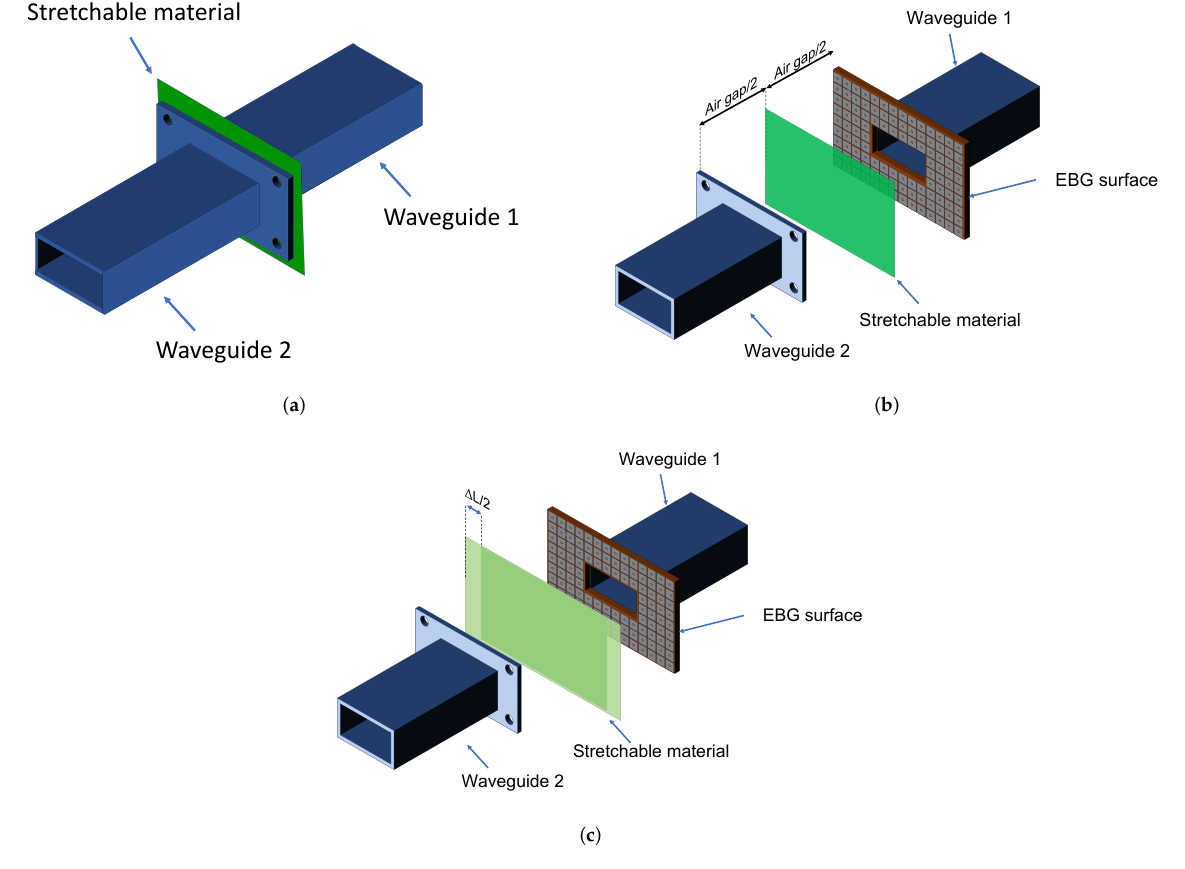
Figure 2. ( a ) STEP 1: Closed waveguide measurement; ( b ) STEP 2: Calibration setup with the material in the unstretched phase in the middle; ( c ) STEP 3: Measurement setup for the contactless estimation of the surface impedance when the material has been stretched by delta